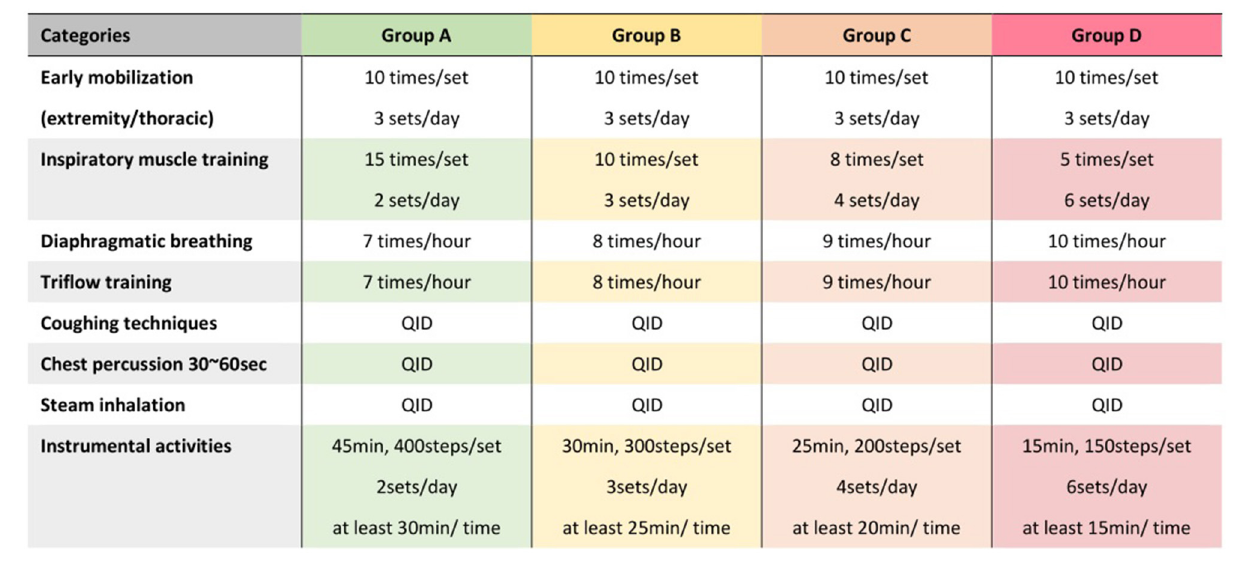
FIGURE 1 | Protocol of perioperative cardiopulmonary rehabilitation for patients with different risk level. Different protocols of perioperative cardiopulmonary rehabilitation were designed for risk levels from group A to group D, respectively, based on the 2016 European Society of Cardiology guidelines ( Table 1